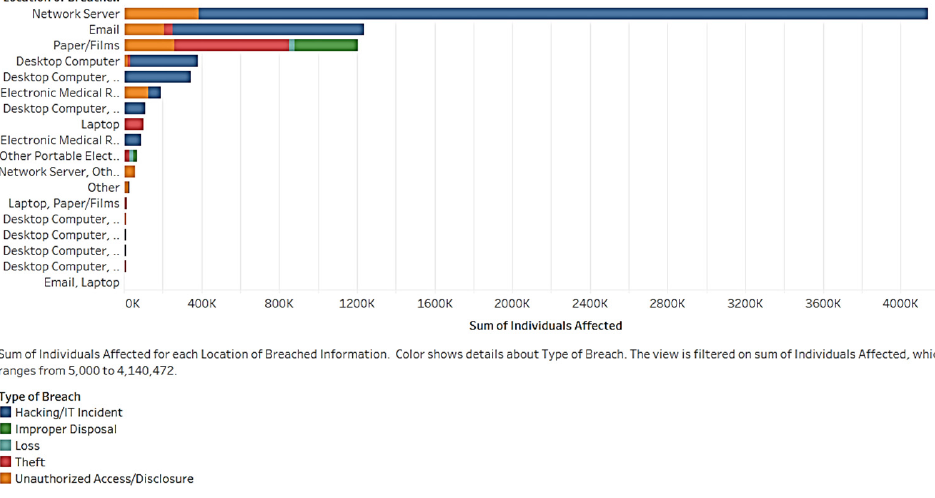
Figure 5. Data breach location vs. number of affected individuals by breach type.